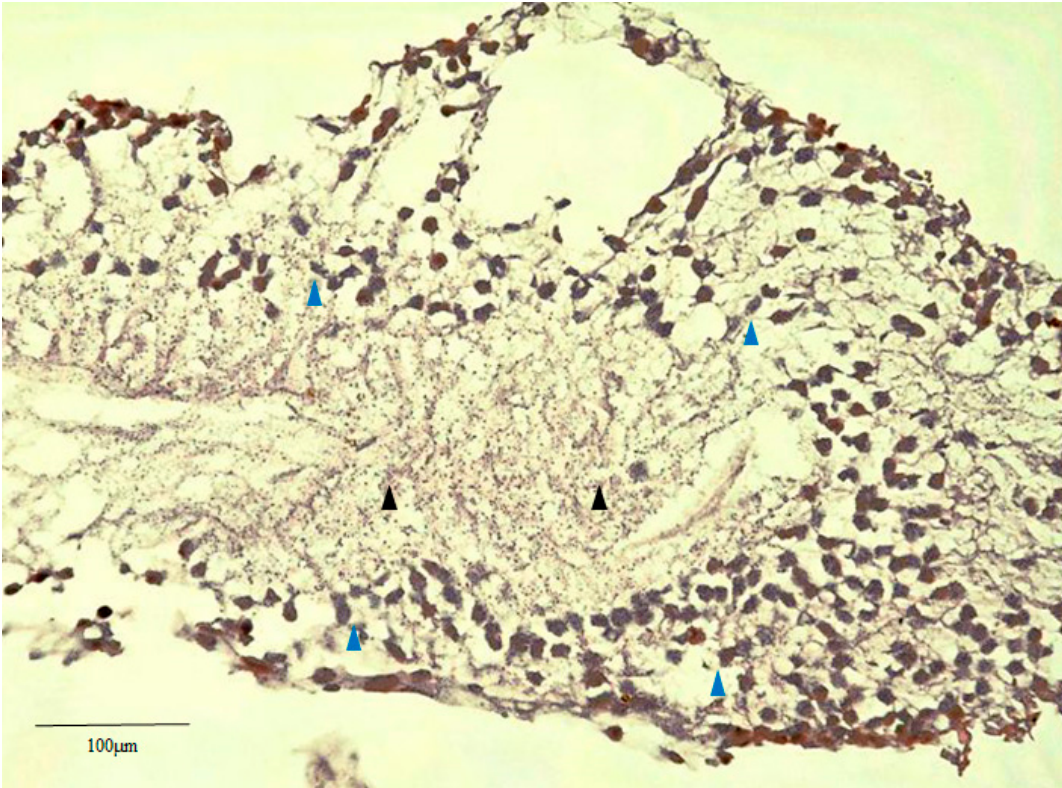
Figure 2. Hematoxylin staining of the obtained retinal lattice degeneration via slicing parallel to the retinal surface. No nucleus was observed in the center of the retinal lattice degeneration (black arrowheads), yet diffuse nuclei were detected in the periphery (blue arrowheads).